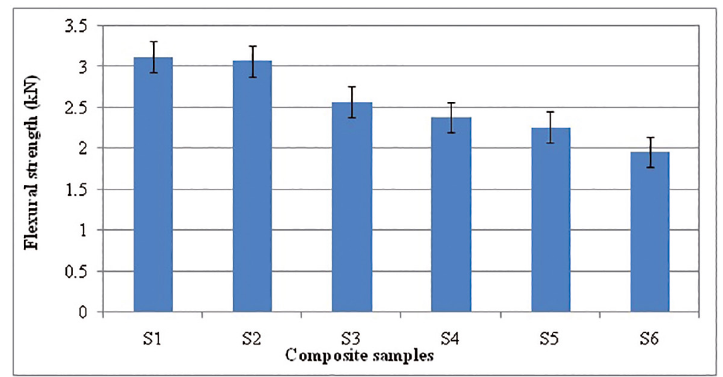
Figure 11: Flexural strength comparison of carbon/banana fiber reinforced hybrid